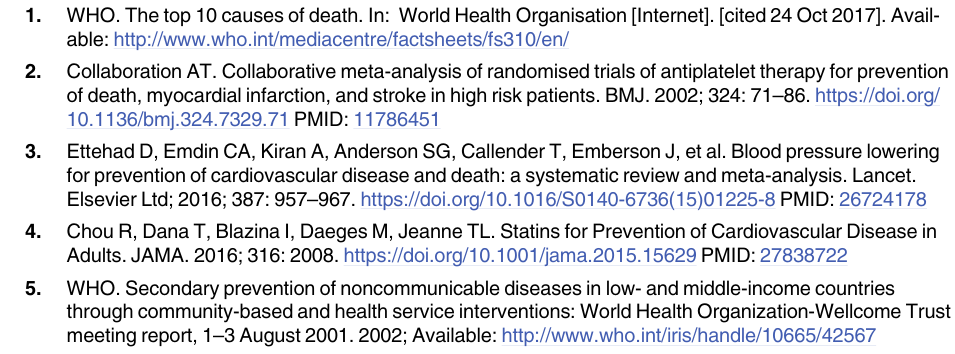
S3 Table. Evidence quality assessment, case-control studies. S4 Table. Relative risk and heterogeneity after excluding studies. S5 Table. Subgroup analysis of demographics and study methodology for all-cause mortal- ity (EBCP versus 0–1 component). S1 Fig. Comparison: EBCP versus 0 EB component, Outcome: All-cause mortality. S2 Fig. Comparison: EBCP versus sub-EBCP ( < 4 components), Outcome: All-cause mor- tality. S3 Fig. Comparison: EBCP versus 0–1 EB component, Outcome: Major CV events. (DOCX) S4 Fig. Galbraith plot for heterogeneity in the primary